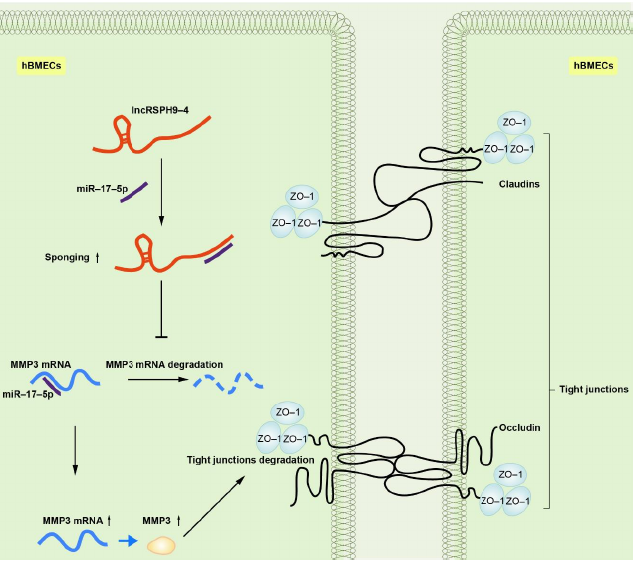
Figure 8. Schematic of the working mechanism of lncRSPH9-4 in the regulation of the endothelial barrier disruption. Meningitic E. coli infection of hBMECs induced the up-regulation of lncRSPH9-4 , which could sponge miR-17-5p and thus increase the expression of MMP3 in hBMECs and finally lead to the tight junction degradation.